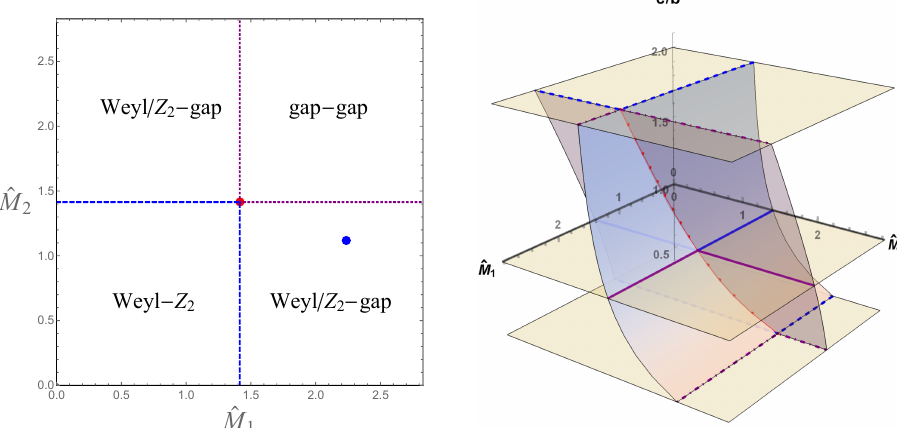
Figure 2. The phase diagram of the system (2.5) with three dimensionless parameters ˆ M 1 = M 1 /b , ˆ M 2 = M 2 /c and c/b = 1 (left plot) and generic c/b (right plot). The red point is the double crit- ical point at which both two pairs of nodes become critical (figure 1b). The vertical blue dashed lines correspond to the critical phase in which two of the Weyl/ Z 2 nodes with opposite topological charges annihilate into a critical Dirac node while the other two nodes still exist (figure 1d, the Weyl/ Z 2 -critical phases). The vertical purple dotted lines correspond to the phase where one pair of Weyl/ Z 2 nodes annihilate into a critical Dirac point while the other pair becomes gapped (figure 1e, the critical-gap phase). The left-down portion of the phase corresponds to the phase in figure 1a. The up left and down right portions of the phase diagram correspond to the phase in figure 1f (i.e. the Weyl/ Z 2 -gap phase). The up right portion of the phase diagram corresponds to the phase figure 1c. The surfaces in the right figure are formed by moving the corresponding critical lines in the param- eter space of c/b . The blue point is to show the location of the double critical point where c/b = 2